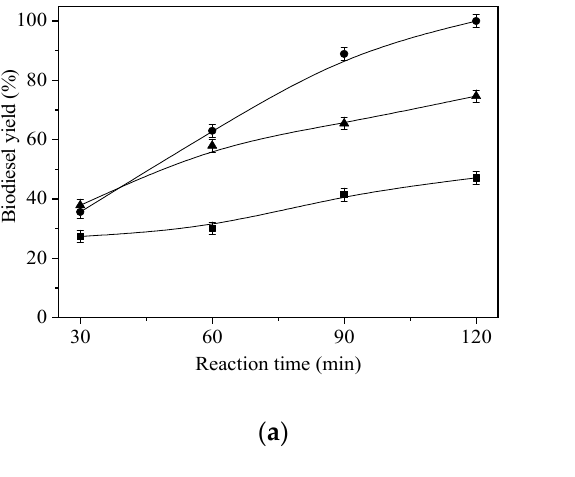
Figure 6. Biodiesel production from macroalgae Fucus vesiculosus oil, ethanol and K 2 CO 3/ γ -Al 2 O 3 /Sepiolite/CoFe 2 O 4 catalyst. In ( a ) Reaction parameters: catalyst mass ( ■ 4%, ● 6% and ▲ 8%) at 70 °C, 200 rpm and 2 h reaction time; ( b ) Reaction parameters: reaction temperature ( ■ 60 °C, ● 70 °C and ▲ 80 °C), catalyst mass (6%), molar ratio (1:12) reaction time (2 h) and 200 rpm.